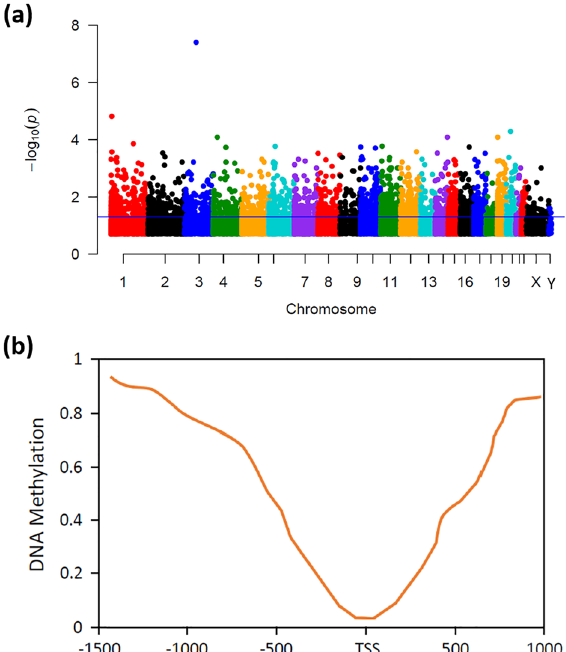
Figure 1. DNA methylation pattern of the CpG sites in prostate cancer. ( a ) Distribution of the CpG sites across the chromosomes. The horizontal straight line (blue) represents the 10 −1.3 (0.05) threshold on the p value. CpG sites that cross the threshold value are considered significant. ( b ) Methylation distribution around the lncRNAs ranging from 1.5 kb upstream to 1 kb downstream of the transcription start site (TSS). Y-axis represents the beta values of the identified CpG sites in Prostate